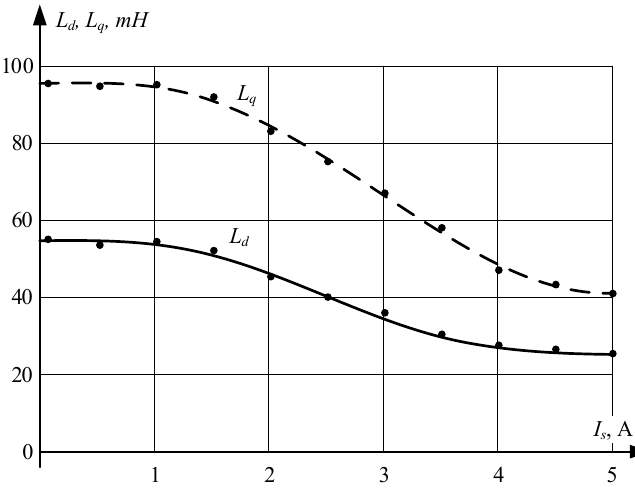
Figure 5. Motor inductances vs. current.